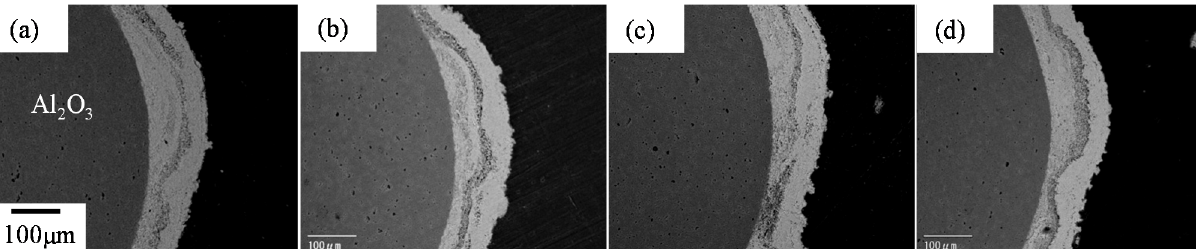
Figure 38. Cross-section SEM images of M10-1273 K- y h samples. ( a ) 3 h, ( b ) 10 h, ( c ) 30 h and ( d ) 50